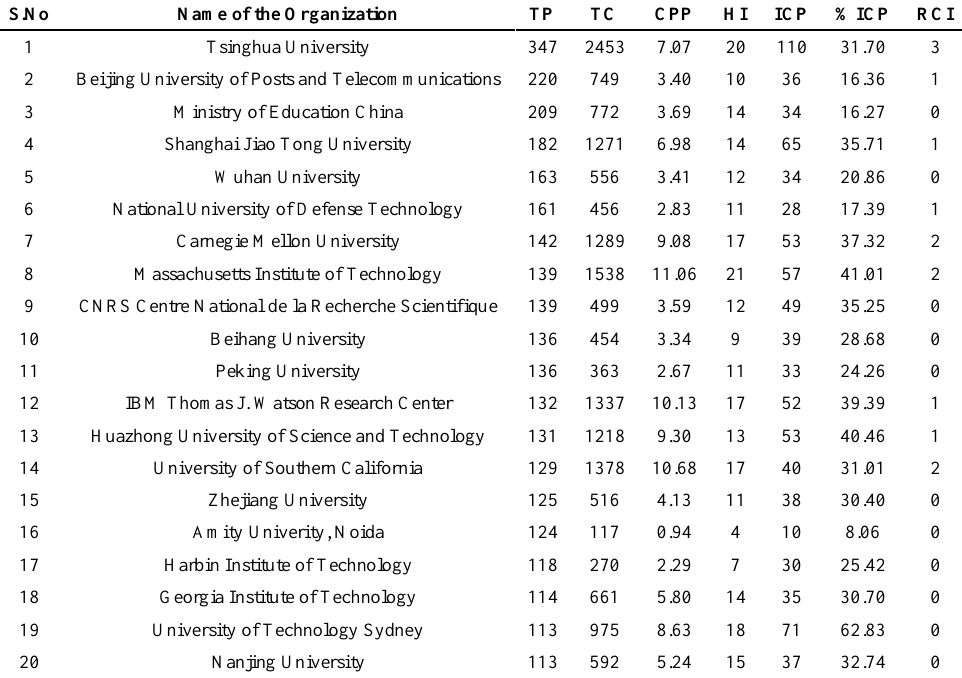
Table 6. Scientometric Profile of Top 20 Global Organizations in Big Data Research by Productivity: 2007-16. S.No